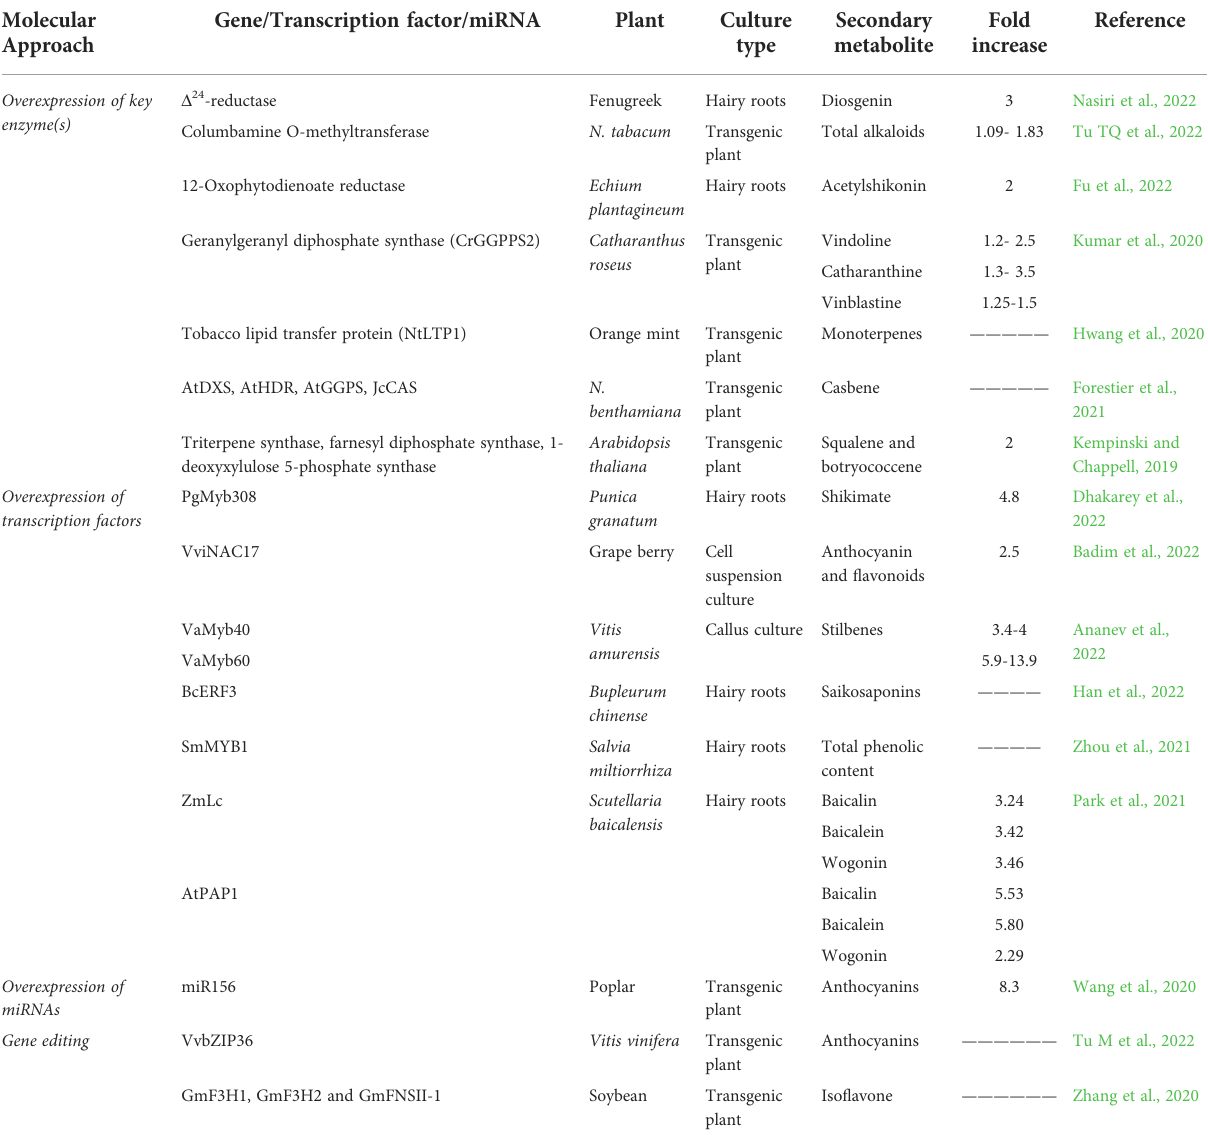
TABLE 2 Enhancement of secondary metabolites by various molecular